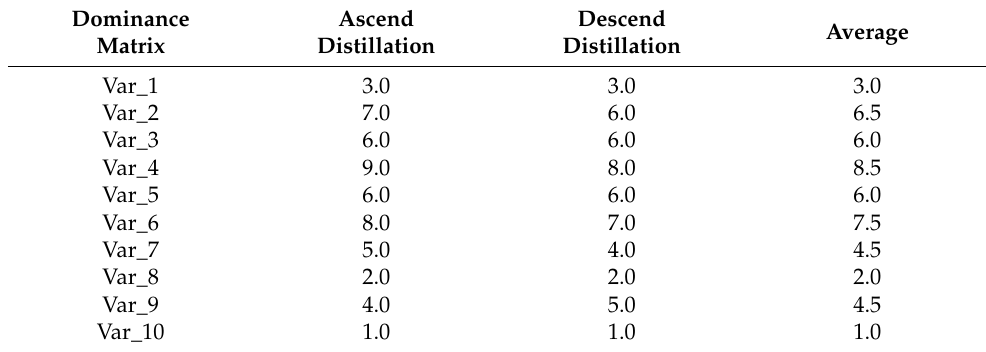
Table 8. Final ranking from the point of view of the surveyed men.